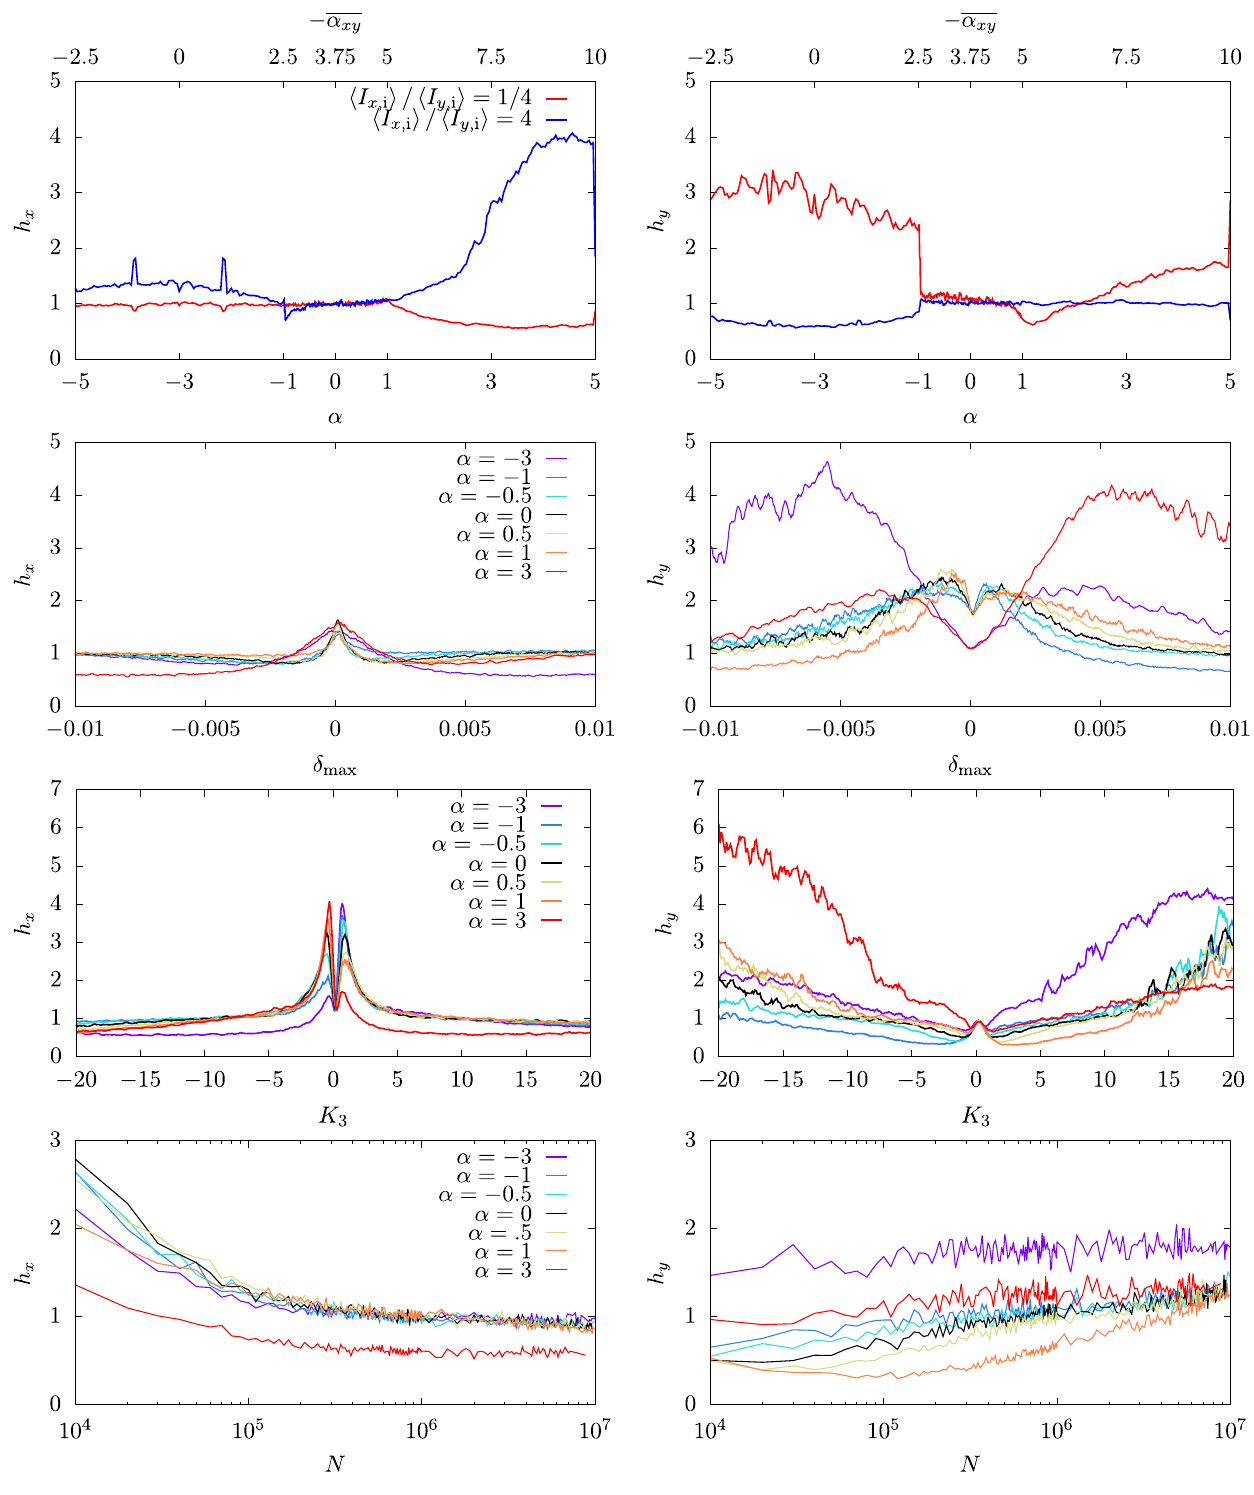
FIG. 10. Simulation results of halo parameters h x (left) and h y (right) as a function of the detuning parameter α for two reciprocal values of the initial emittance ratio (first row), frequency excursion δ (second row), normal octupole strength K 3 (third row), and max number of turns N (fourth row). Seven values of α representing all possible regimes have been used. A positive value of δ indicates max > ω > ω δ < 0 . Data are shown after applying a moving average of five values. a process where ω y; x y; f and vice versa for i max 0 . 01 , K 10 , N ¼ 10 6 , N 10 4 , h I 1 × 10 − 4 , (Simulation parameters: ω x ¼ 2 . 602 , β x ¼ β y ¼ 1 , α xx ¼ α yy ¼ 0 , δ 3 ¼ p ¼ x; i i ¼ max ¼ h I y; i i ¼ 4 × 10 − 4